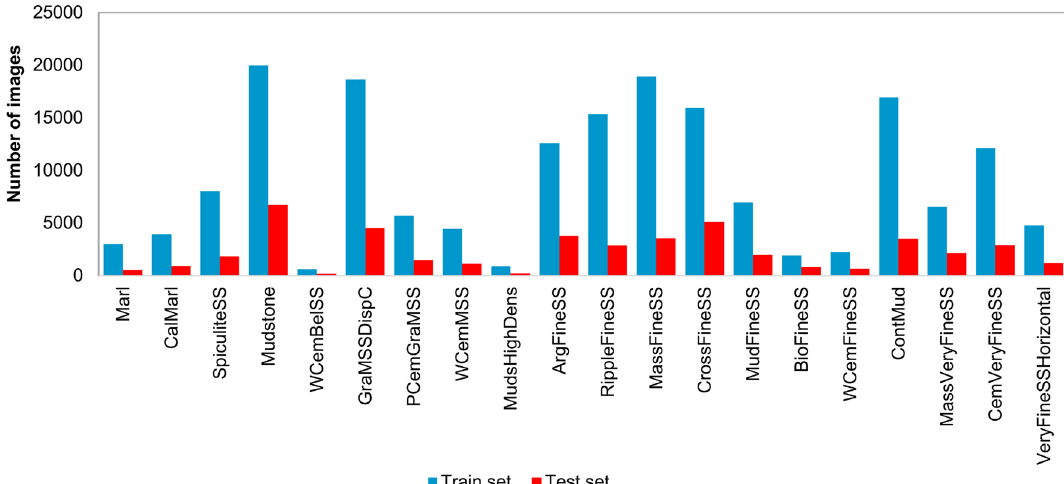
Fig. 6 Distribution of different lithofacies classes in the train (blue) and test (red)